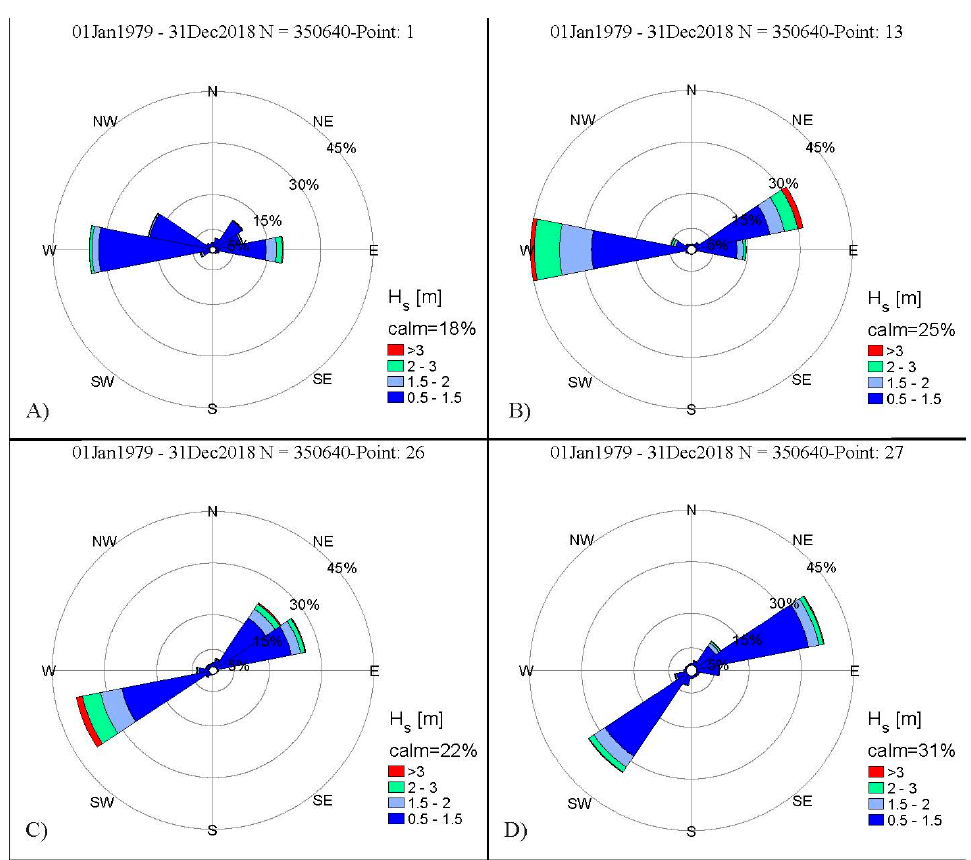
Figure 3. Significant wave height roses obtained considering the time span from 1 January 1979 to 31 December 2018 for ERA5 point nos. 1 ( A ), 13 ( B ), 26 ( C ), and 27 ( D ).